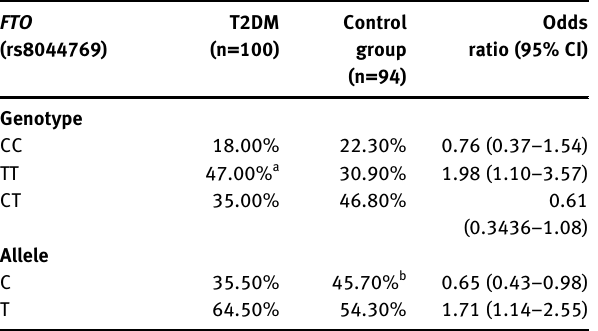
Table  : Distribution of FTO (rs  ) genotypes and alleles in type  diabetes mellitus patient and control groups.